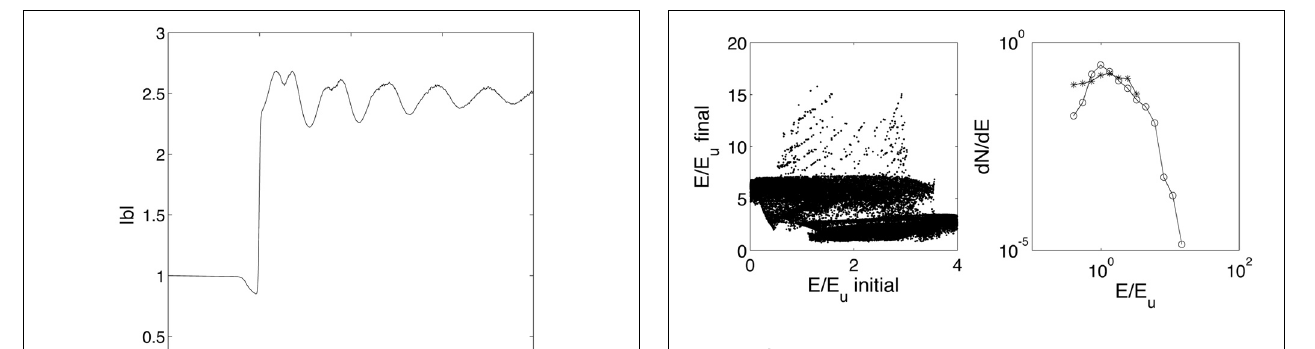
FIGURE 5 | Left: Initial vs. final energies. Right:energy spectrum upstream (stars) and downstream (circles). For the shock with θ = 80 ◦ , s = 0 . 5, and D = 0 . 2.